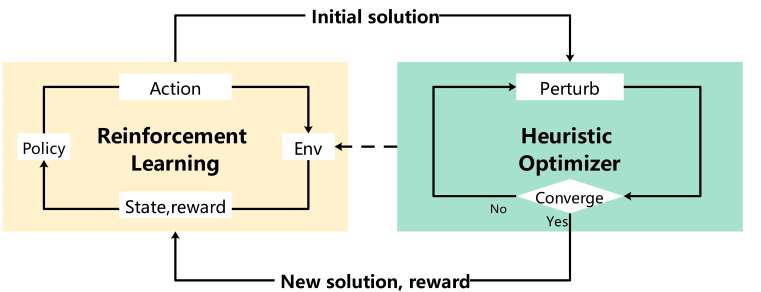
Figure 5. The reinforcement learning (RL)-driven heuristic optimization framework. This framework consists of the RL agent and the heuristic optimizer. The RL agent generates the initial solution for the heuristic optimizer. Then, the heuristic optimizer completes the execution until convergence conditions are met and returns a new solution and reward to the RL agent for